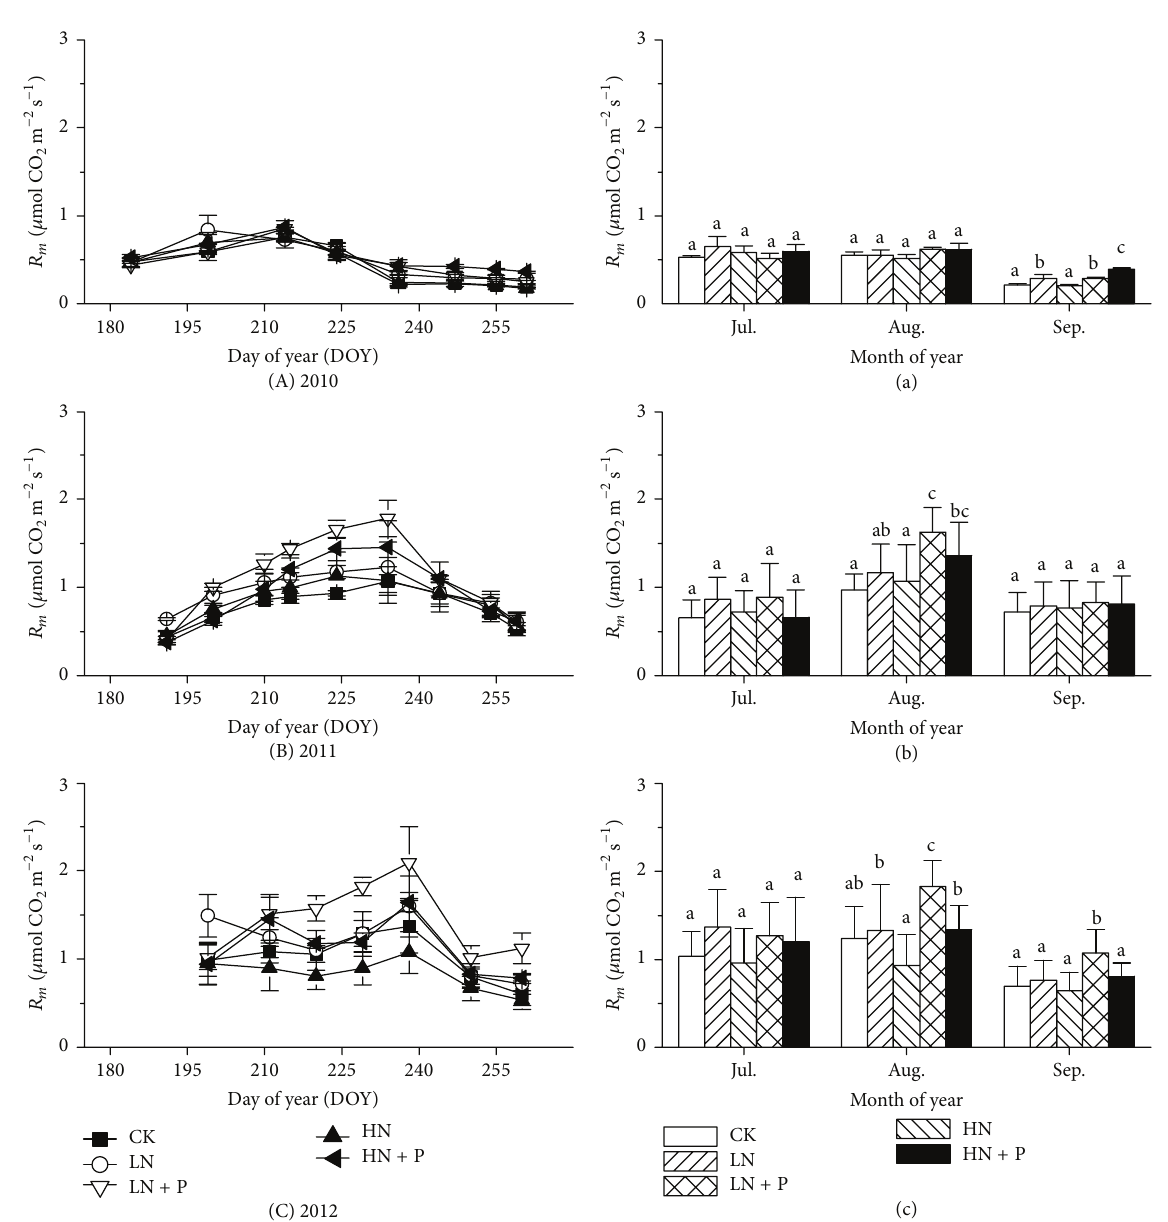
Figure 1: Seasonal variations (A, B, and C) and monthly mean values (a, b, and c) of soil microbial respiration during the 2010, 2011, and 2012 growing seasons. Bars sharing the same letters indicate no significant difference at P < 0.05 significant level. LN, HN, LN + P, and HN + P represent low N (5 gN m −2 yr −1 ), high N (10g Nm −2 yr −1 ), low N combined with P ((5g N + 5g P)m −2 yr −1 ), and high N combined with P ((10gN + 5g P)m −2 yr −1 ), respectively, and in the control treatment (CK) neither N nor P was